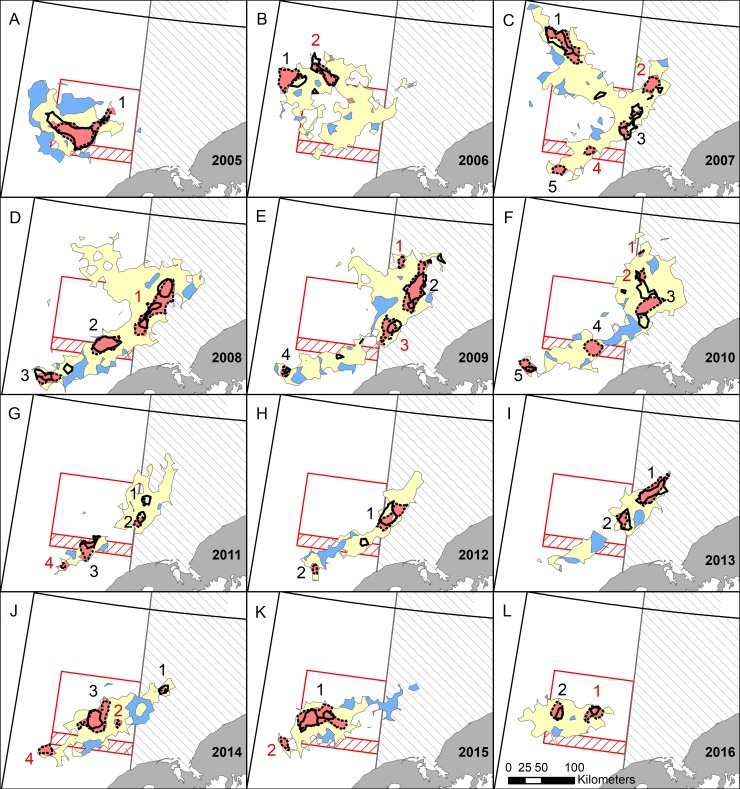
Red king crab distributions using daily fishing logs (DFLs) from the entire season.Red, blue, and yellow areas indicate locations where fishing occurred each fishing season (October 15th–January 15th). Red areas are detectable hot spots (Gi* indicating statistically significant (α < 0.01) high catch per unit effort (CPUE)); blue areas are detectable cold spots (Gi* indicating statistically significant low CPUE); yellow areas indicate locations where CPUE was not statistically different from the mean. Black dashed lines are high-high areas using the local Moran’s I statistic on DFL data and solid black lines are hot spots using observer data (Gi* statistic). Hot spots are numbered in color for each year, black when they occur in both the full dataset (this figure) and the first 5% (Fig 5) and red when they occur in just one dataset. Areas with restrictions on trawling are outlined in red or gray and are described in Fig 1.